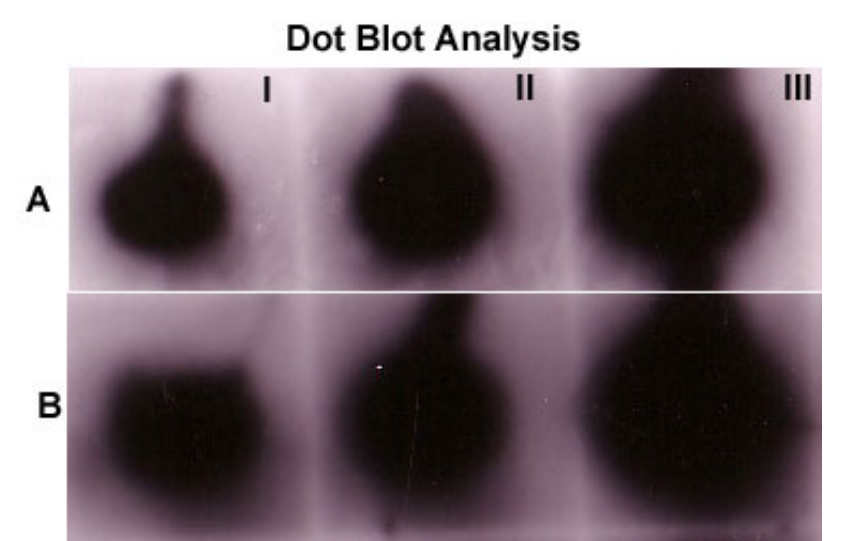
Figure 2. L. quinquestriatus ( A ) and A. crassicauda ( B ) venoms were incubated in membranes 2 µL (I), 3 µL (II) and 4 µL (III); venom proteins reacted strongly with RSHC anti-Ac (1:1000).